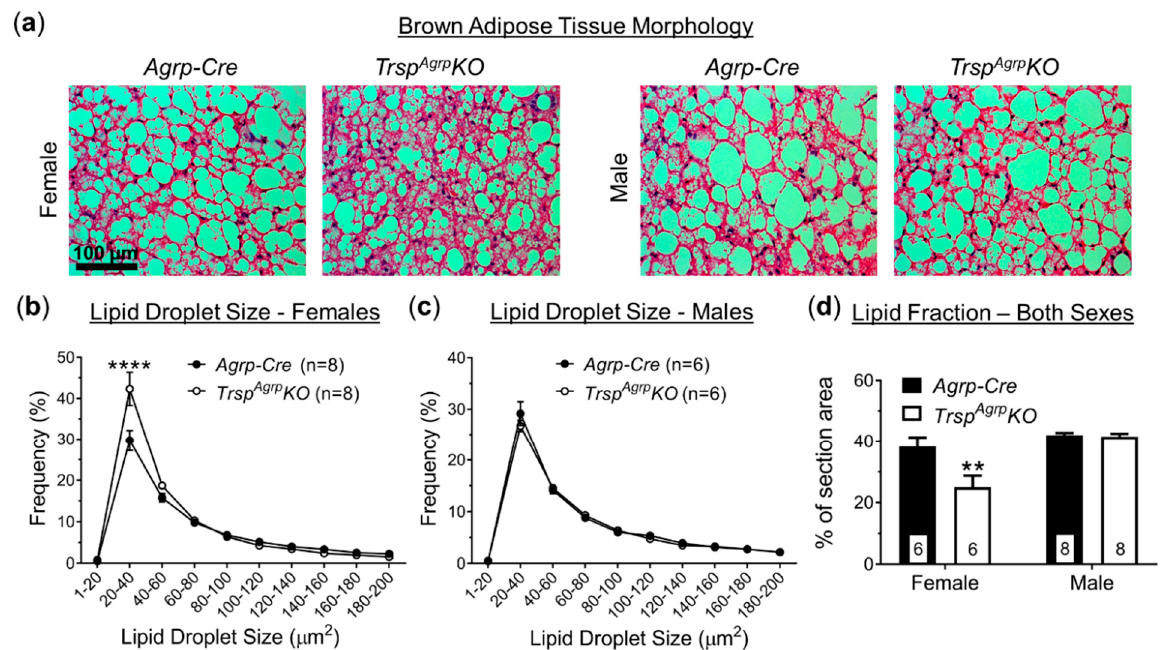
Figure 3. Brown adipose tissue morphology of Trsp Agrp KO mice of both sexes raised on a high-fat diet. ( a ) Sample images of hematoxylin and eosin-stained brown adipose tissue sections from female and male Trsp Agrp KO and Agrp-Cre control mice. ( b ) The size of lipid droplets measured sections from female Trsp Agrp KO mice was more frequently present in smaller sizes compared to female Agrp-Cre control mice (two-way repeated-measures analysis of variance followed by Sidak’s multiple comparisons: **** p < 0.0001). No changes were seen in male mice. ( c ) Average lipid fraction, which is the percentage of the section occupied by lipid droplet, was significantly lower in female Trsp Agrp KO mice compared to Agrp-Cre control mice ( d ) (two-way analysis of variance, followed by Tukey’s multiple comparisons test: ** p = 0.007). Samples sizes are displayed in the graphs. All values shown are mean ± standard error of the mean.